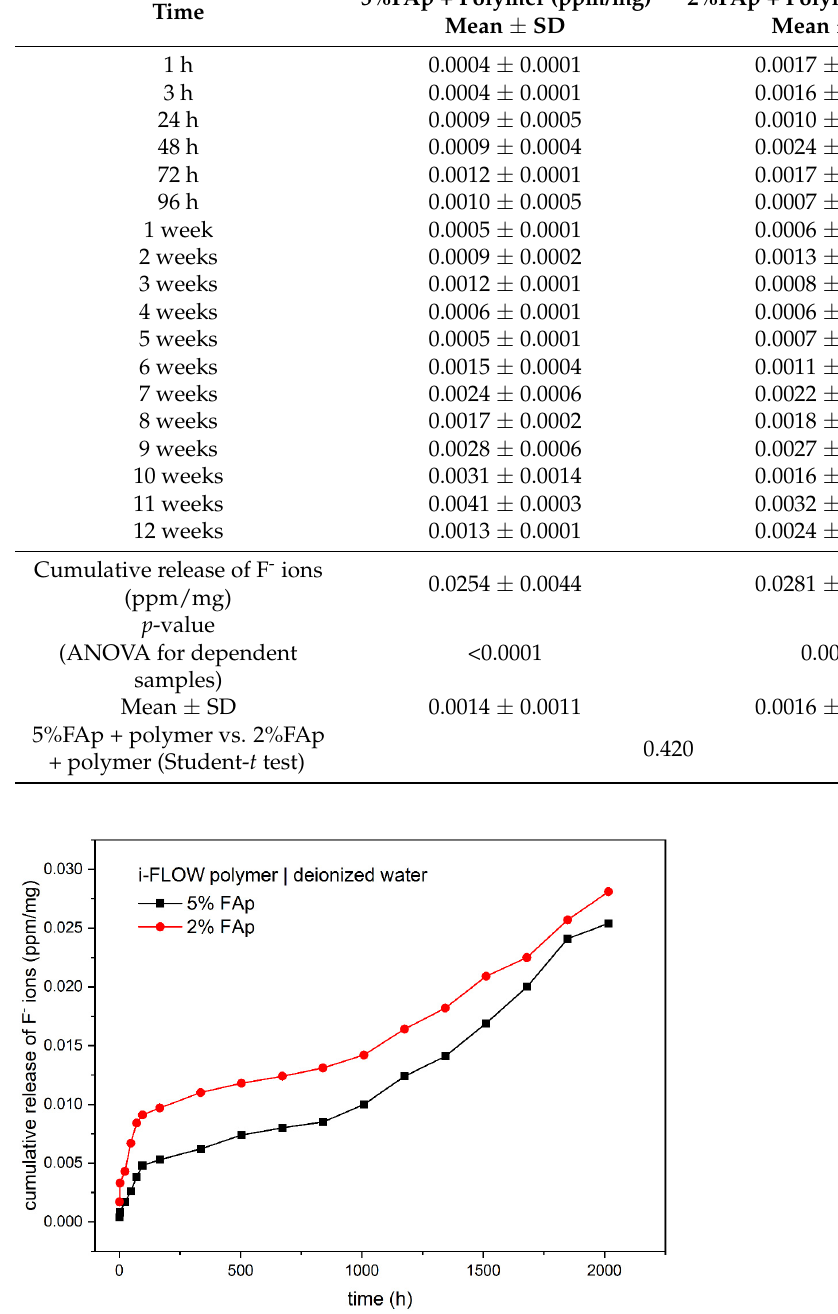
Figure 5. Cumulated release of fluoride ions (ppm/mg) from two study materials into deionized